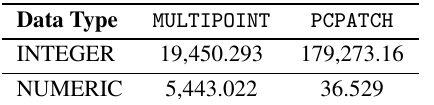
Table 5. The query times based on two different data type using the dataset. All times are in